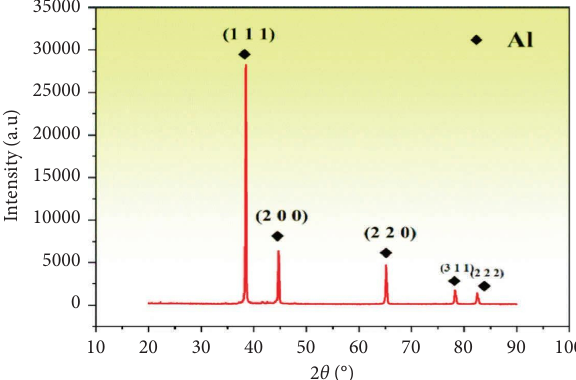
Figure 14: XRD analysis of specimen bonded at 500 °